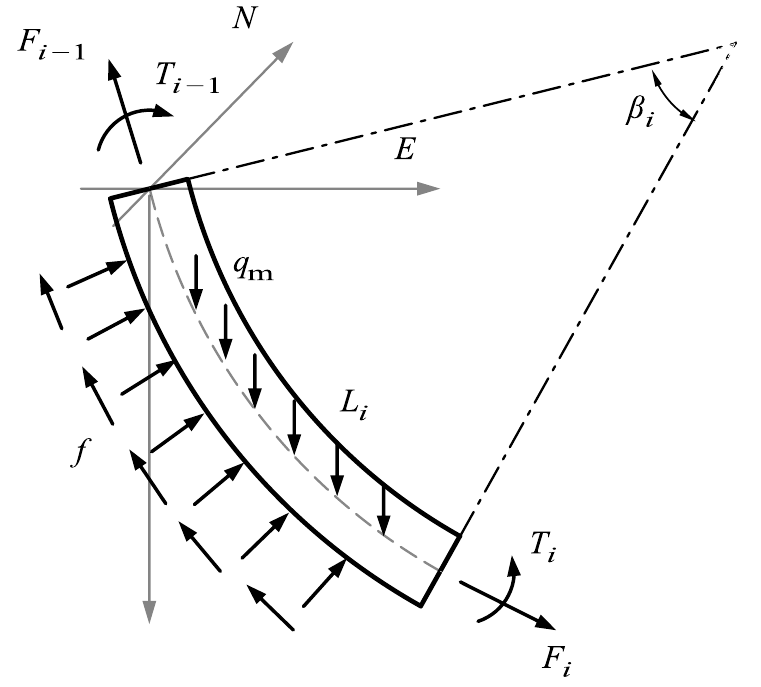
Figure 1. Force analysis for drill string unit [42].